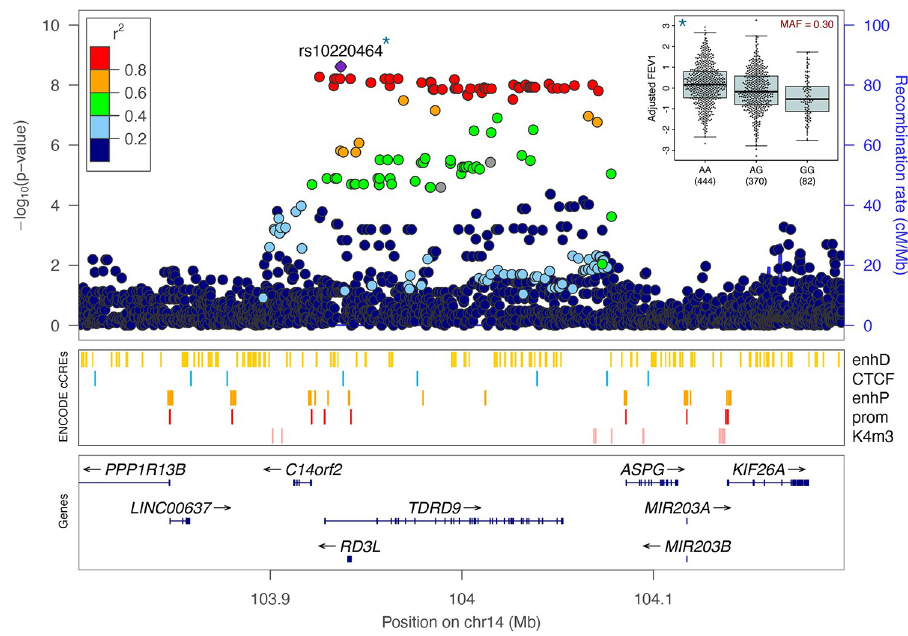
Fig 3. FEV 1 -associated variants on chromosome 14q32.33. FEV 1 association results are shown at the TDRD9 gene locus. Each variant is plotted according to its position and -log 10 p-value, colored by linkage disequilibrium to the lead variant, rs10220464, within the sample. Candidate cis-Regulatory Elements (cCREs) from ENCODE [59] are also shown for the region. The inset panel in the upper right shows the distribution of adjusted FEV 1 values by rs10220464 genotype. FEV 1 , forced expiratory volume in one second; MAF, minor allele frequency; EnhD, distal enhancer-like signature; CTCF, CCCTC-binding factor sites; enhP, proximal enhancer-like signature; prom, promoter-like signature; K4m3, trimethylation of histone H3 at lysine